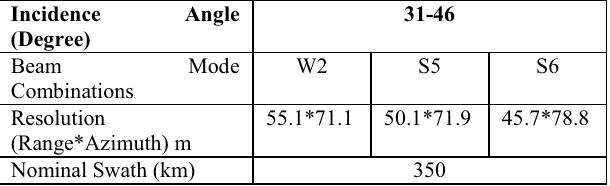
Table 2: Specifications of RADARSAT ScanSAR Narrow-2